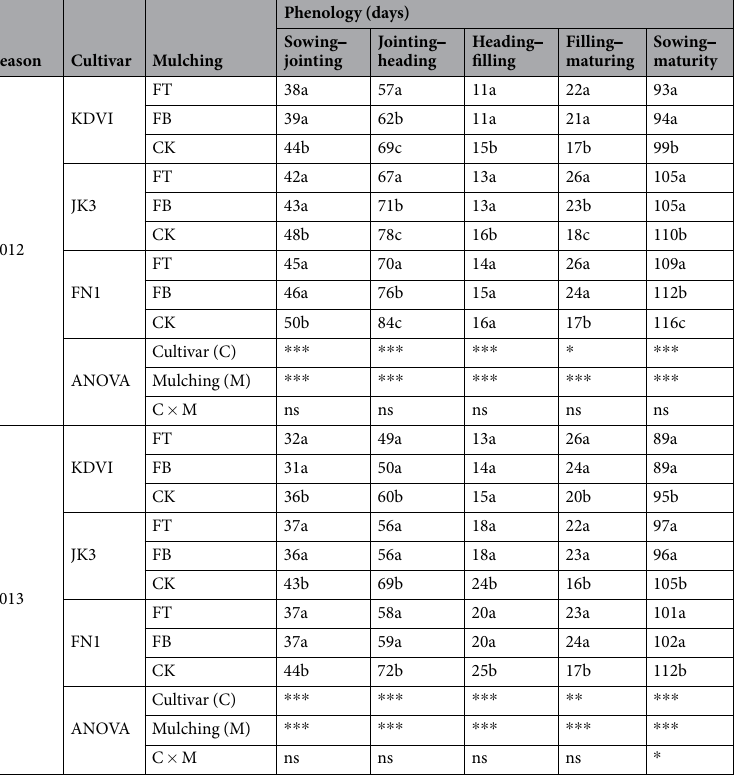
Table 2. Phenology as affected by maize cultivars (early- mid- and late-maturing, KDVI, JK3 and FN1, respectively) and ridge-furrow differingin mulching materials (FT, alternative ridge-furrow with transparent film mulching; FB, alternative ridge-furrow with black film mulching and CK, alternative ridge-furrow with no mulching) in both growing seasons, on a sandy clay loam in Kenya, east African Plateau. Values followed by the same letters in each cultivar are not significantly different at p < 0.05 level. * , ** and *** significant at p < 0.05, 0.01 and 0.001 level, respectively; ns, not